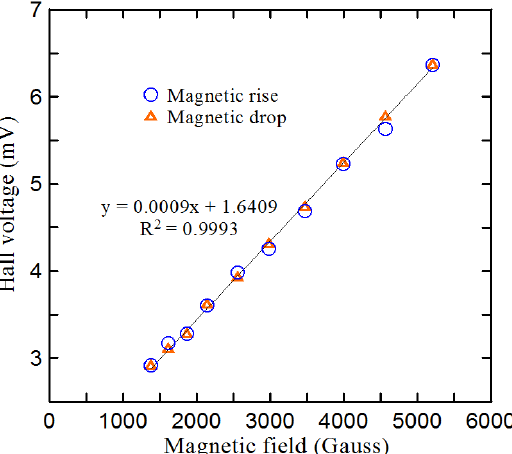
Figure 8. Magnetic hysteresis curve for the Hall sensor of size S at 10 mA of working current.